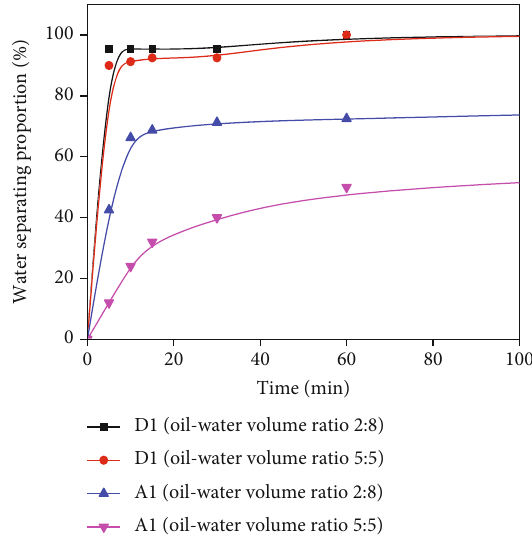
Figure 6: The water separating proportion of viscosity reducing surfactant A1 and D1 at di ff erent oil-water volume